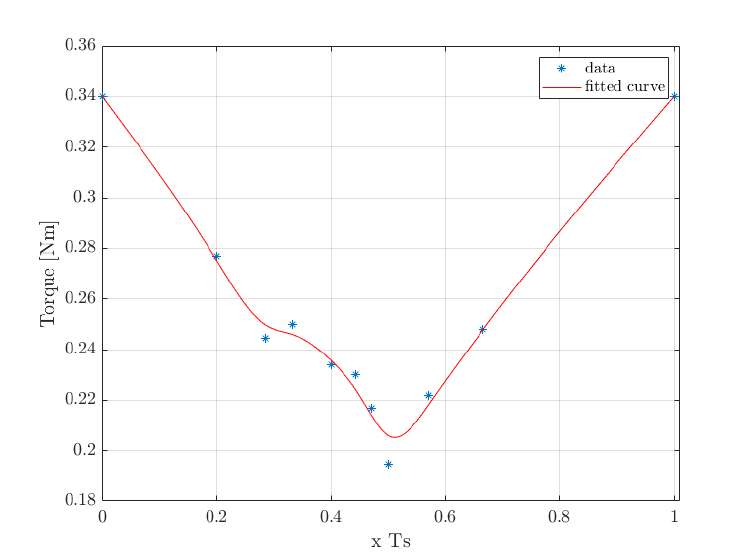
Figure 16. Torque amplitude measured at the first resonance mode with different delay times of the interleaving